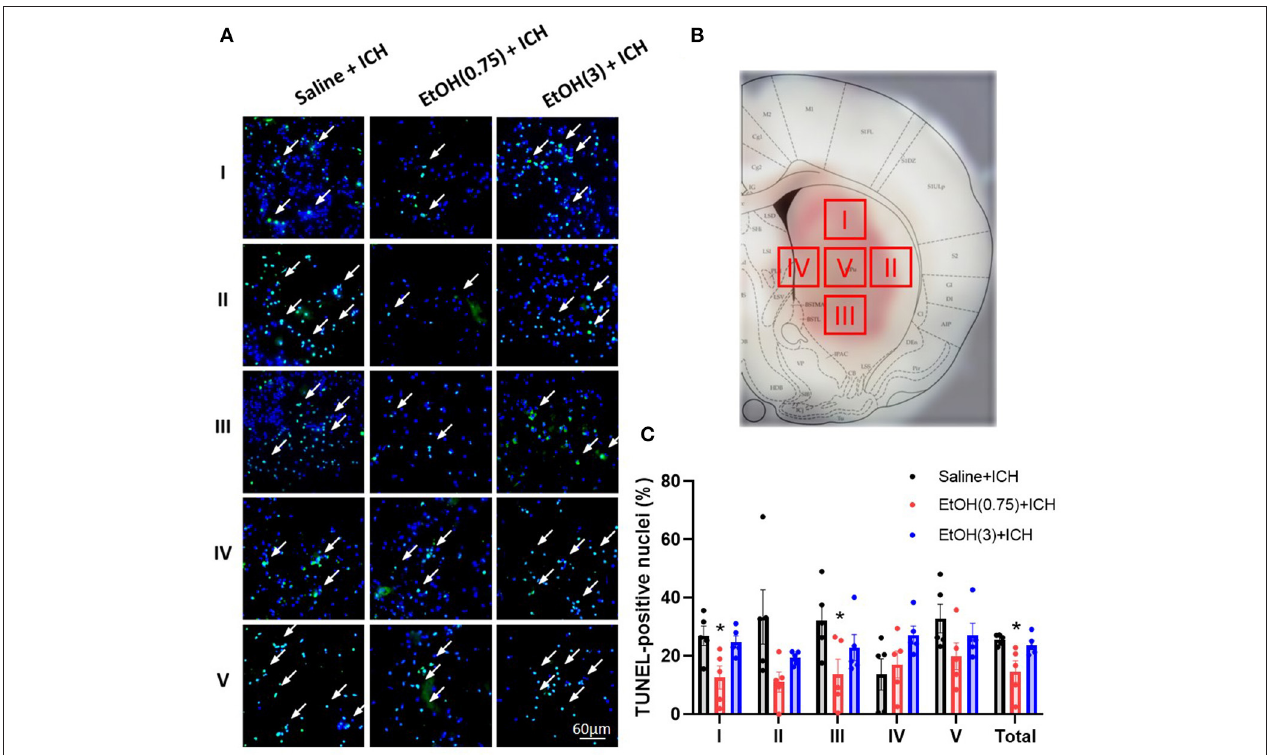
FIGURE 7 | Moderate ethanol pre-conditioning reduced ICH-induced apoptosis in striatal regions. (A,B) Representative TUNEL-positive staining of apoptotic cells (A) in four regions around the peri-hematoma area ( B , Regions I–IV) and core region ( B , Region V). (C) The statistical measurement of ICH-induced apoptotic cells in each group. Values are shown as means ± SEM ( n = 5). * p < 0.05 as compared to Saline + ICH